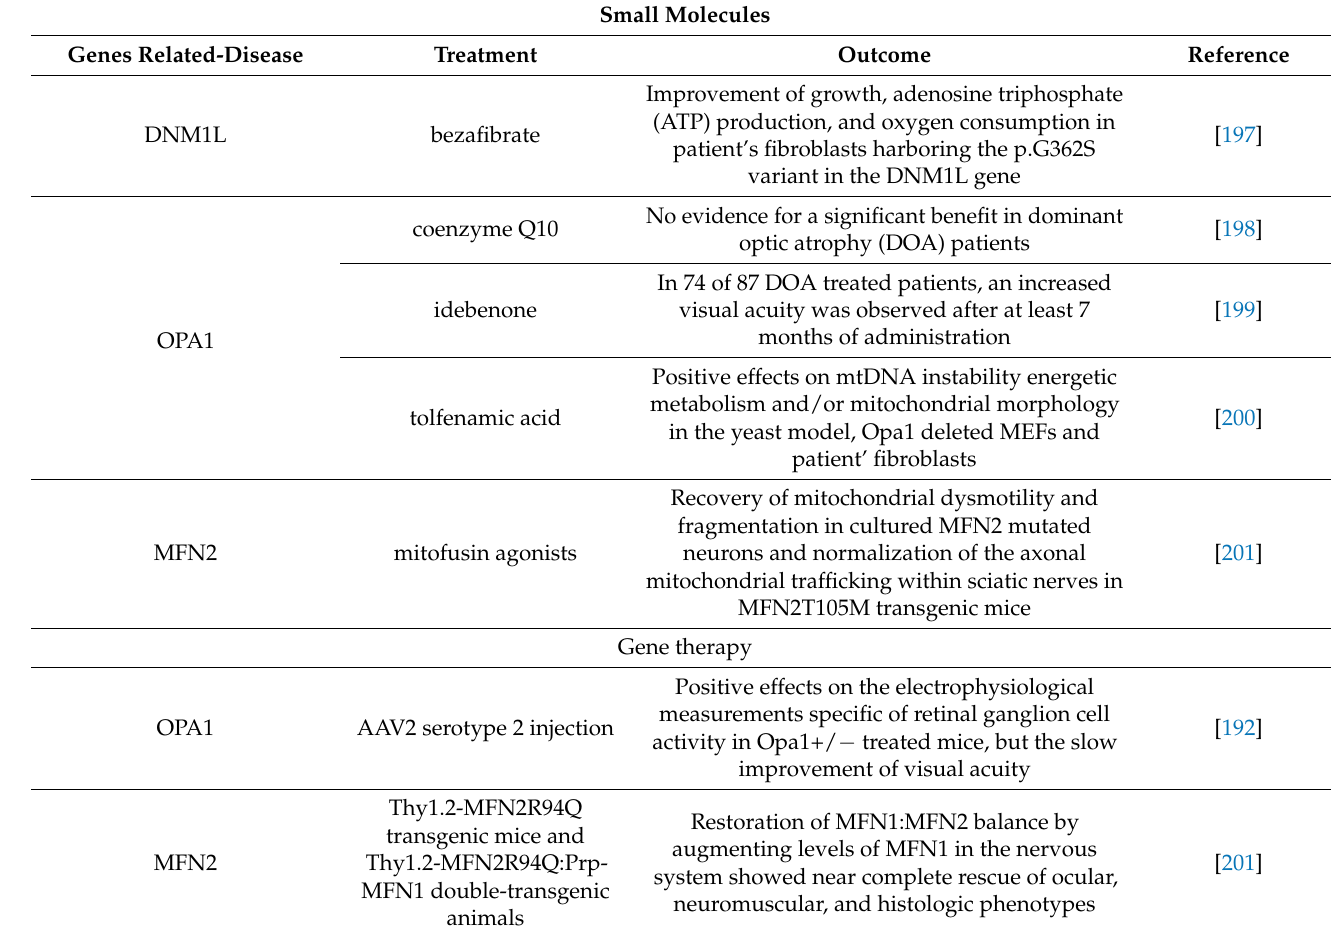
Table 1. Therapeutic